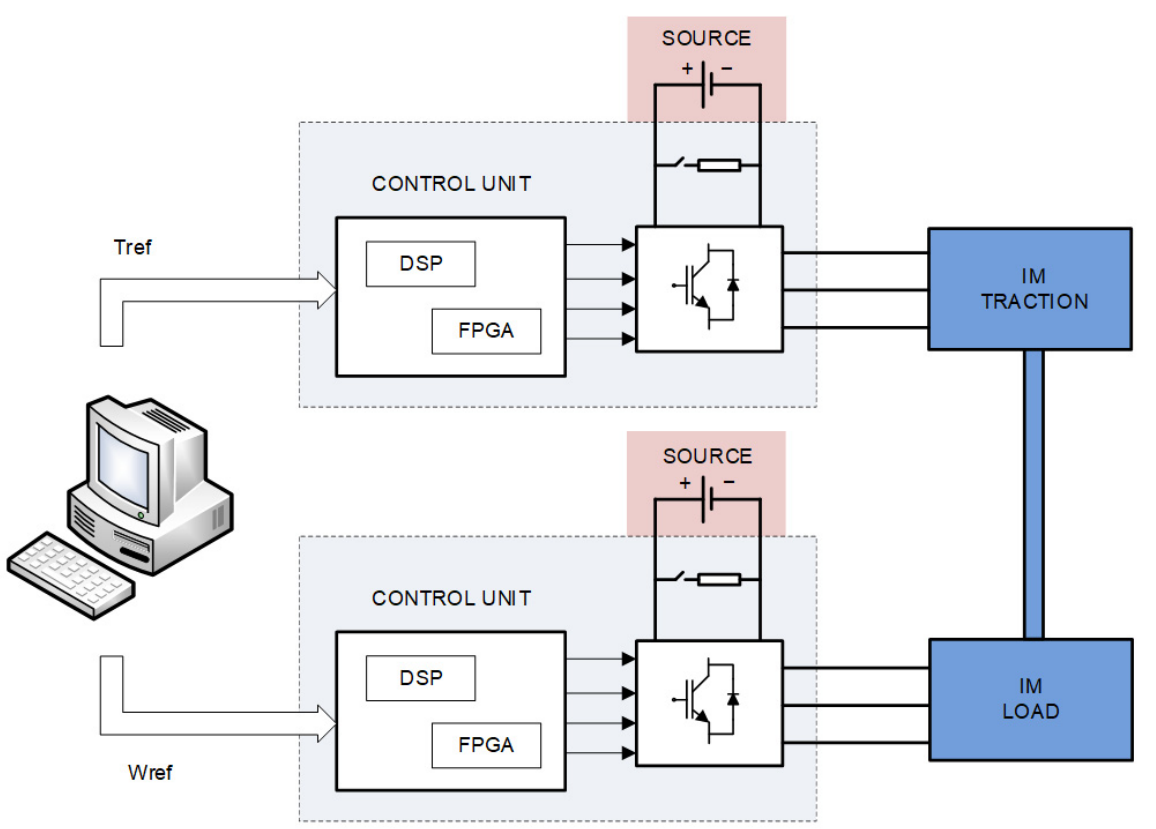
Figure 4. Test bench structure diagram.